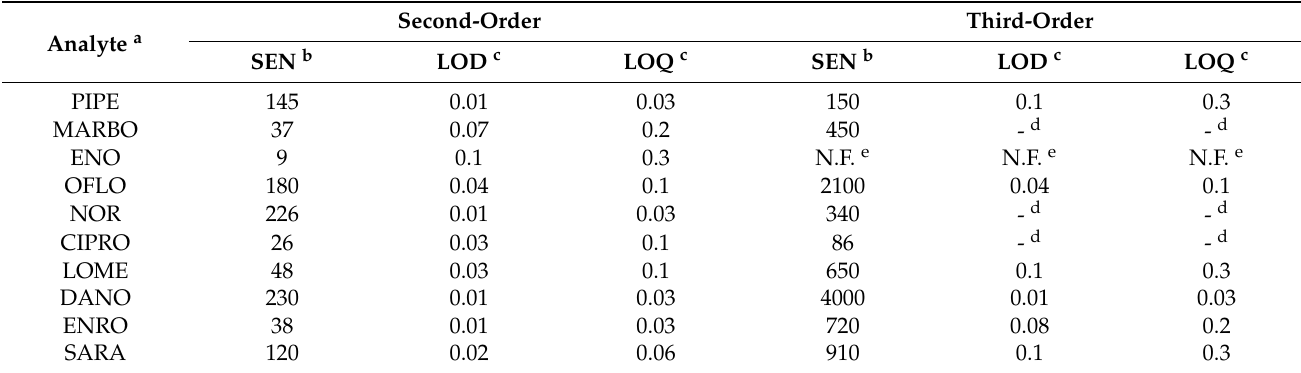
Table 3. AFOMs from second- and third-order calibration of a number of fluoroquinolone antibiotics using MCR-ALS. Data from ref.